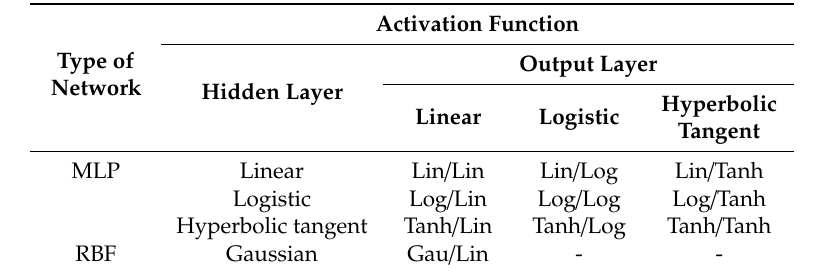
Table 2. Configurations of activation functions in the hidden and output layer neurons examined during the architecture optimization process of MLP and RBF neural networks describing mold